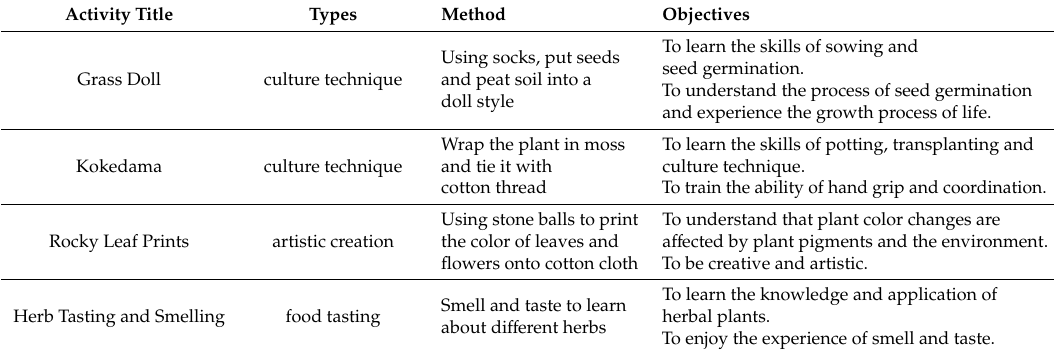
Table 1. Activity titles, types, and objectives of the healthy horticultural activity